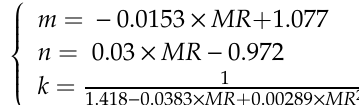
Figure 16. The relationship between oil–pressboard mass ratio ( MR ) and parameters m , n , and k . ( a ) The relationship between m and MR . ( b ) The relationship between n and MR . ( c ) The relationship between k and MR